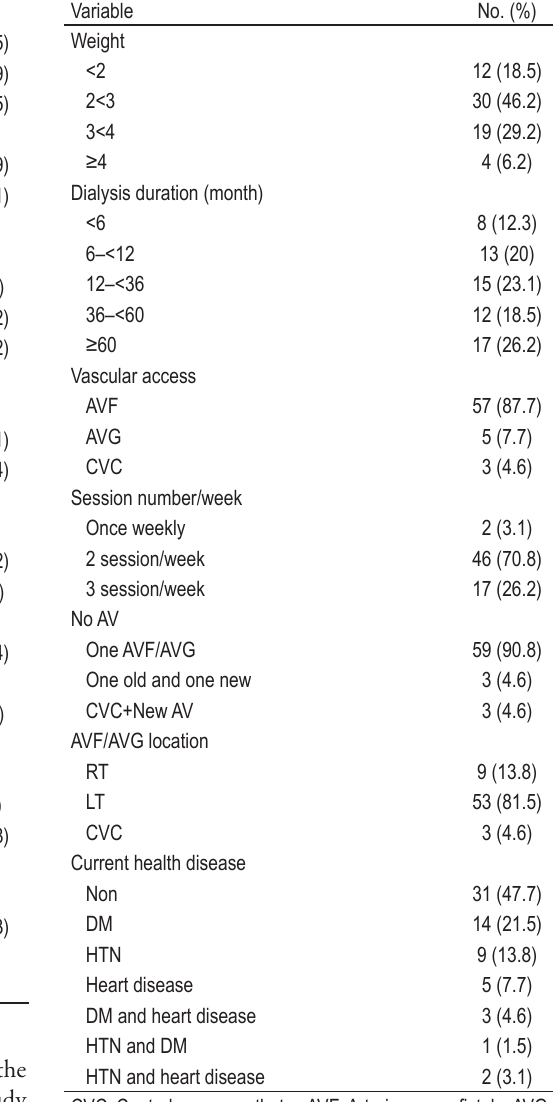
TABLE 1. Socio-demographic characteristics of patients in the study sample (n=65)